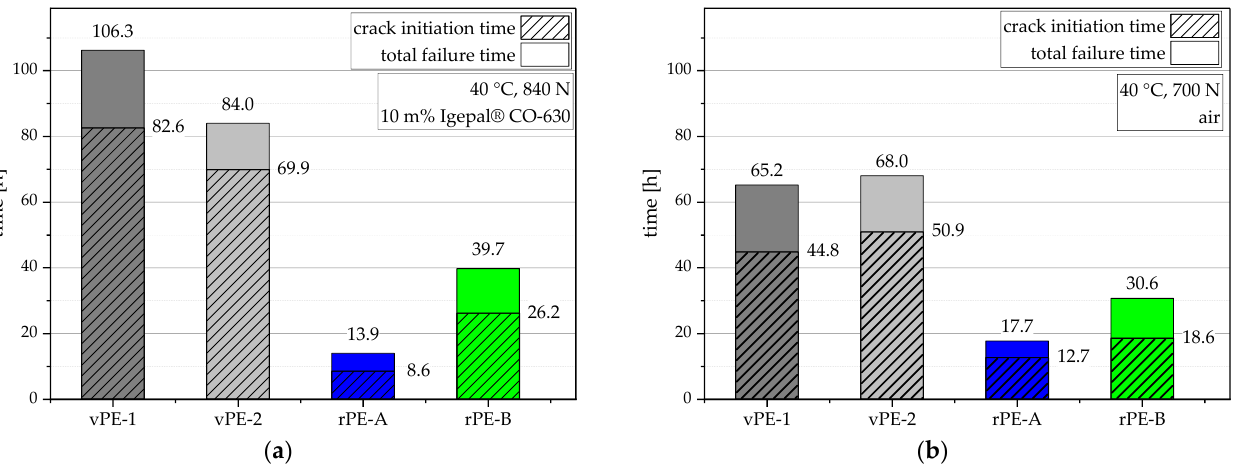
Figure 10. Graphical illustration and values of crack initiation times and total failure times at 40 °C in a solution of deionized water and 10 m% Igepal CO-630 ( a ) and in air ( b ).